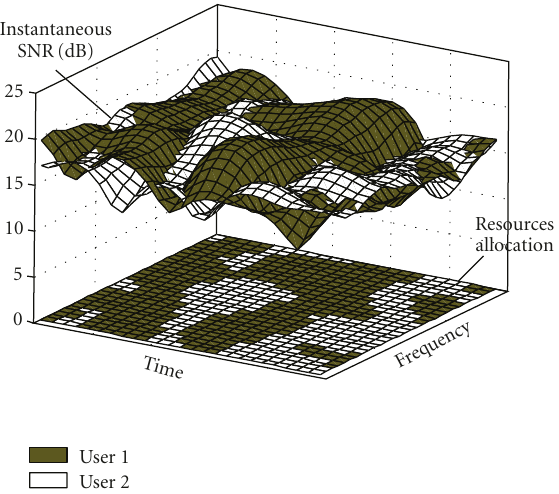
Figure 3: Example of cross-layer scheduling for two users [2].